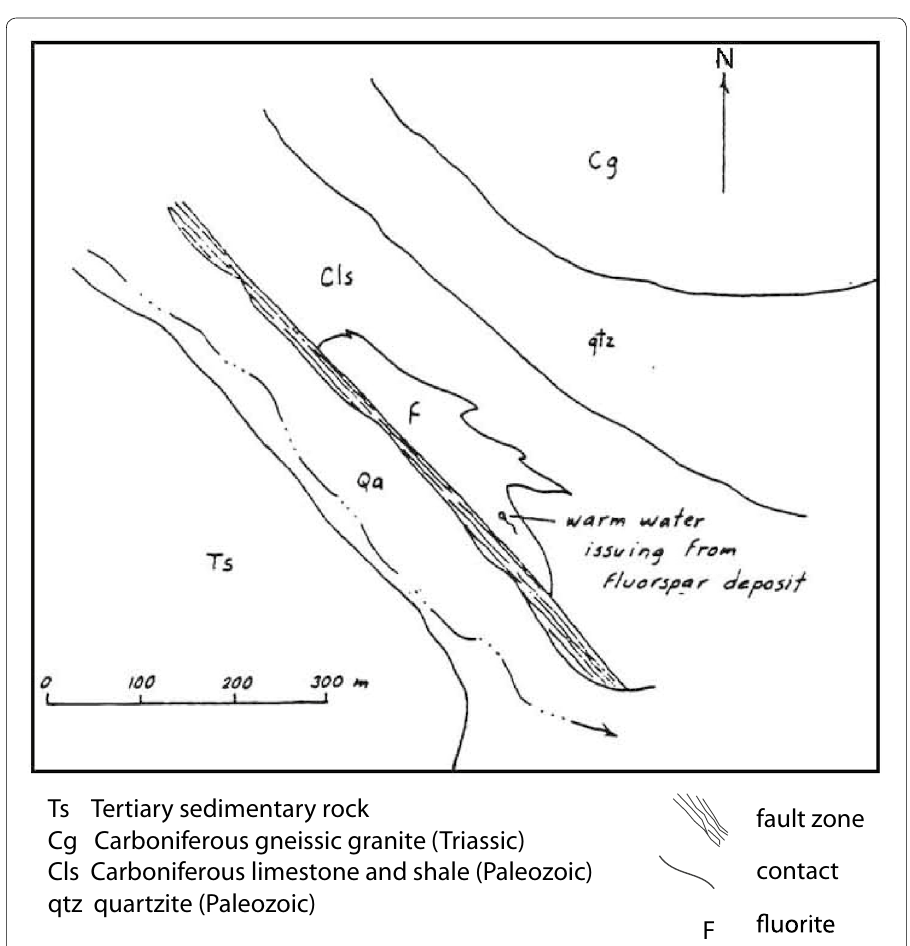
Fig. 13 Sketch map of the Huai San fluorite mine made by Shawe (1984) showing location of warm springs in the mine. Carboniferous ages assumed at the time are now considered early Paleozoic sediments and Trias- sic